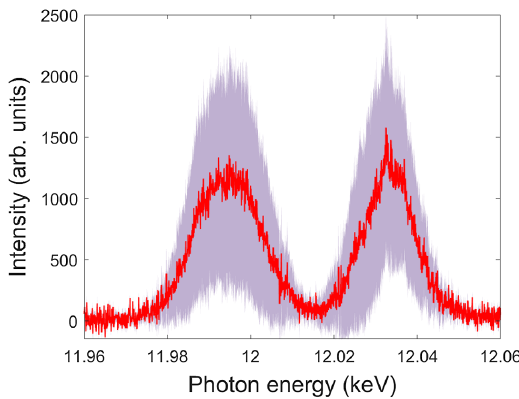
FIG. 4. Two-color FEL spectra. The red curve shows the average intensity and the light-purple area displays the statistical scattering recorded over 6000 consecutive